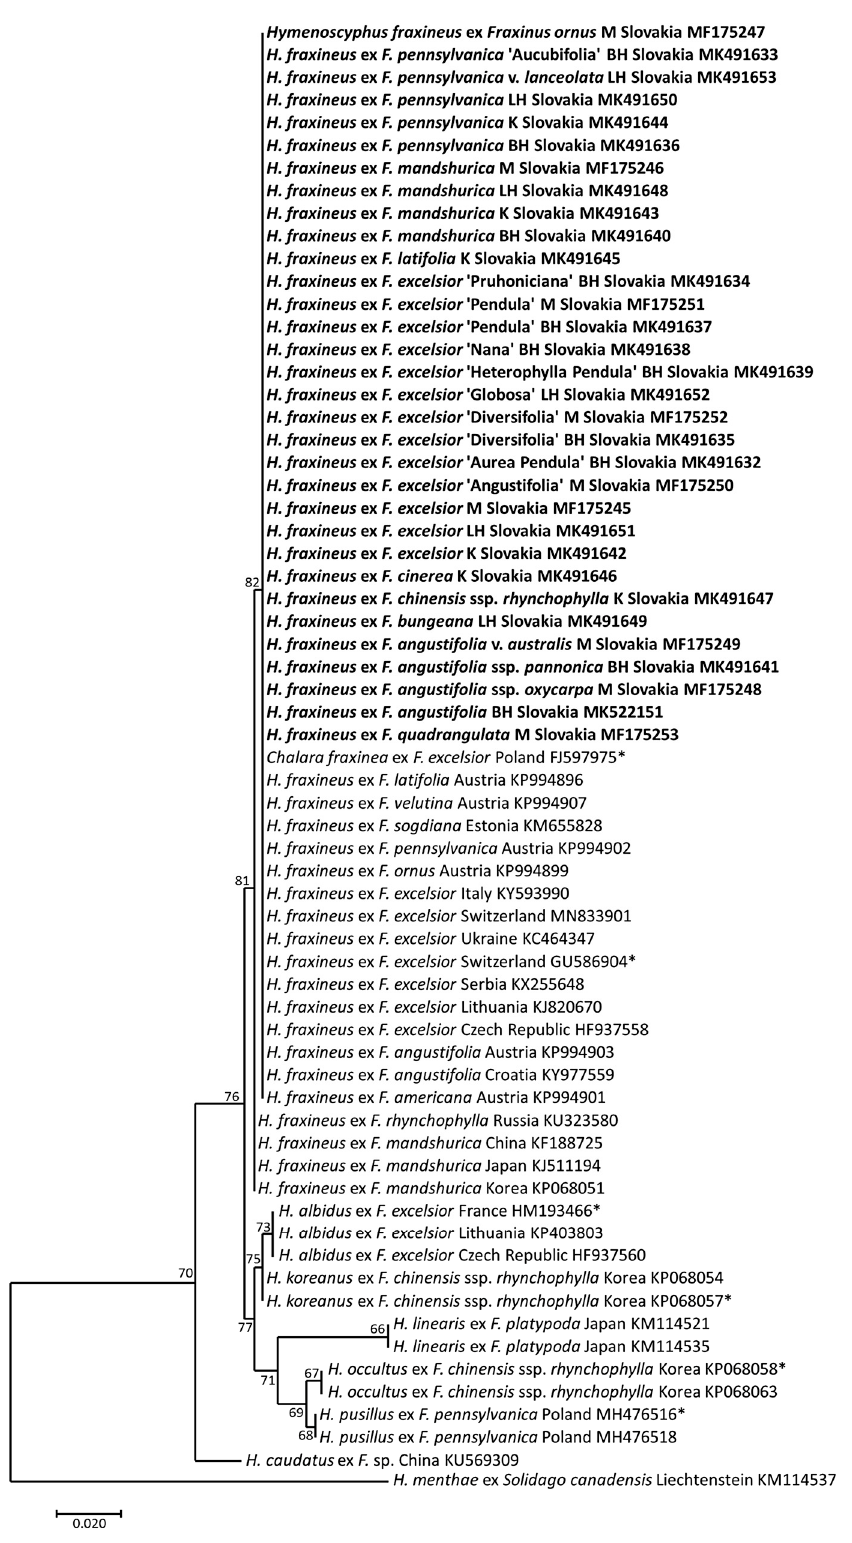
Figure 6. Maximum likelihood tree based on ITS rDNA sequences of Hymenoscyphus spp. The bootstrap values > 60% are indicated at the nodes. The scale bar indicates the number of substitutions per site. Material collected in Slovak arboreta (BH—Borová hora, K—Kysihýbel, LH—Liptovský Hrádok, M—Mly ň any) and sequenced in this work are shown in bold type. Sequences from type materials are marked with an asterisk (*).